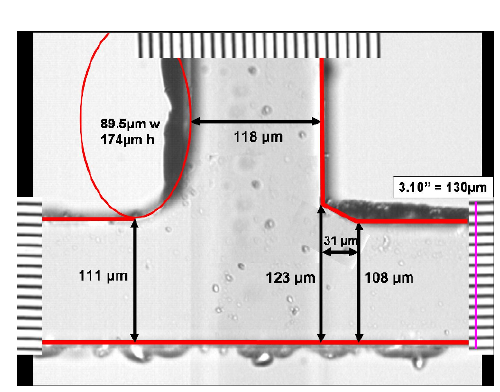
Figure 2. Microfluidic T-junction chip